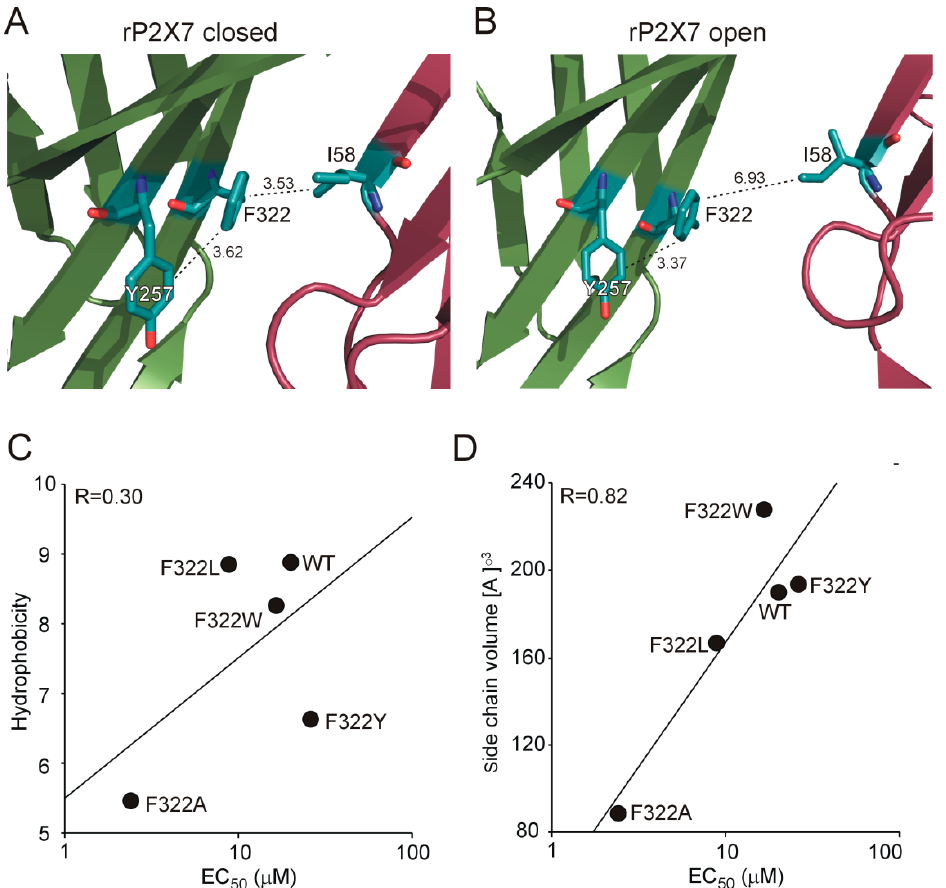
Figure 7. The possible interactions of F322 with other residues in β -sheets of the same or neighboring rP2X7 subunit. ( A ) In the apo-closed state of rP2X7, F322 can interact with Y257 of the same subunit (3.62 Å) or I58 of the neighboring subunit (3.53 Å). ( B ) While the positions of Y257 and F322 are not substantially changed in the ATP-bound open state (3.7 Å), the positions of F322 and I58 are remote in the open state (6.93 Å). ( C ) Correlation between the log EC 50 values and the hydrophobicity of the amino acid side chain substituent. ( D ) Correlation analysis between the log EC 50 values and the volume of the amino acid side chain substituent. The model represents the rP2X7 receptor in the closed (PDB ID: 6U9V) and open (PDB ID: 6U9W) states [31].